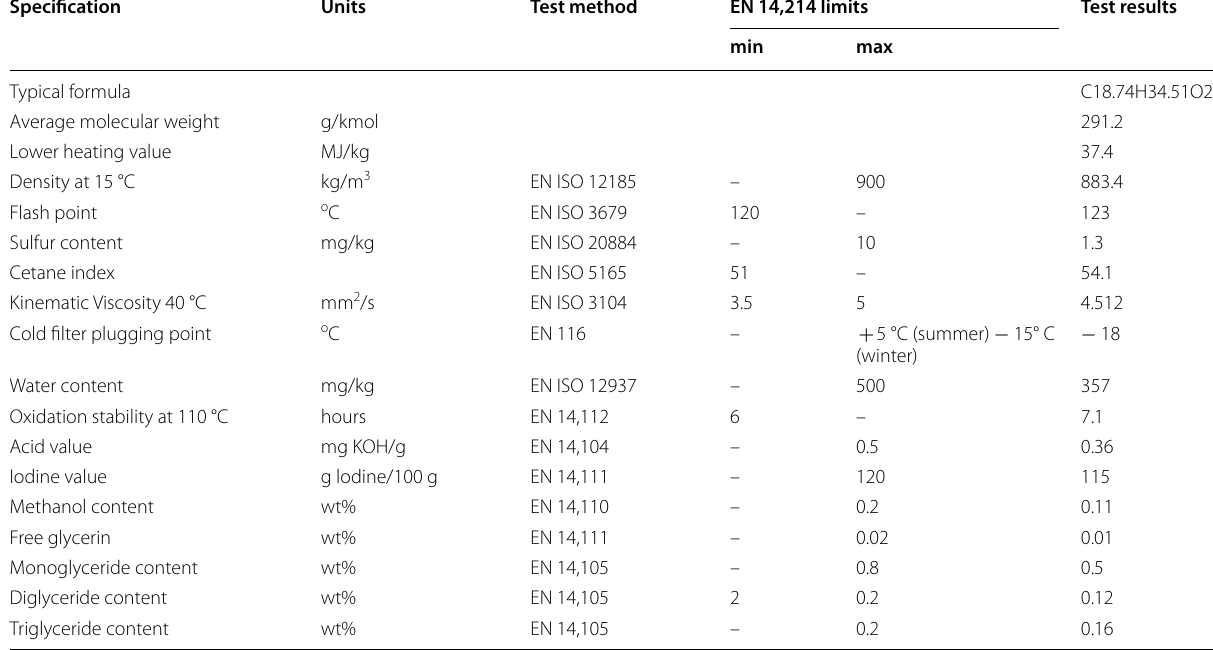
Table 3 Properties of soybean biodiesel